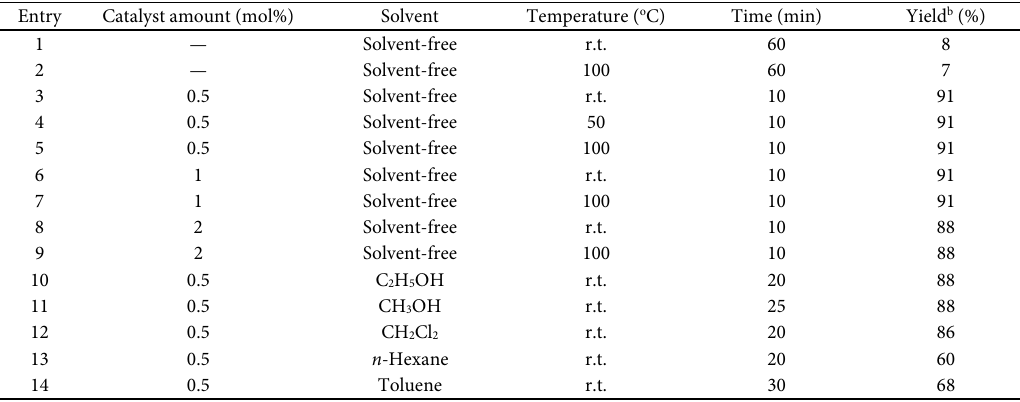
Table 4. Synthesis of biscoumarins using {[2,2'-BPyH][C(CN) 3 ] 2 }. a